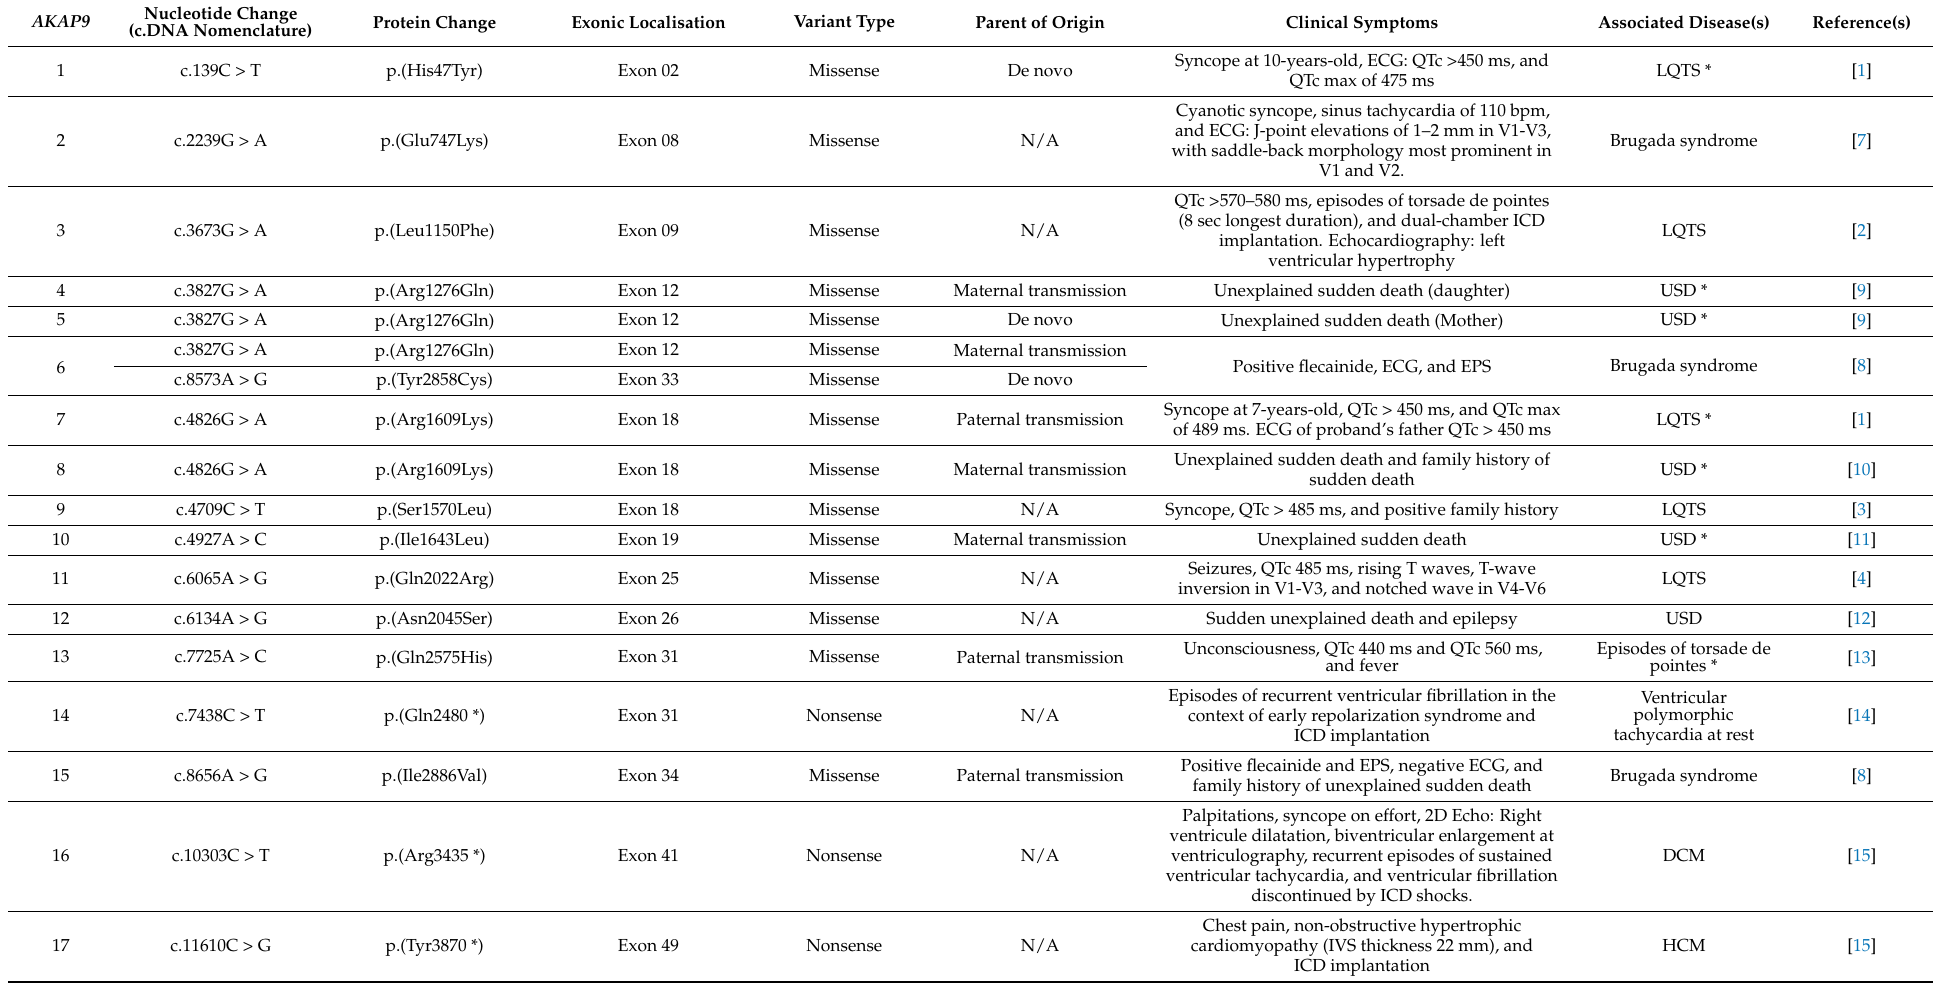
Table 1. Previously reported AKAP9 variants associated with different cardiac